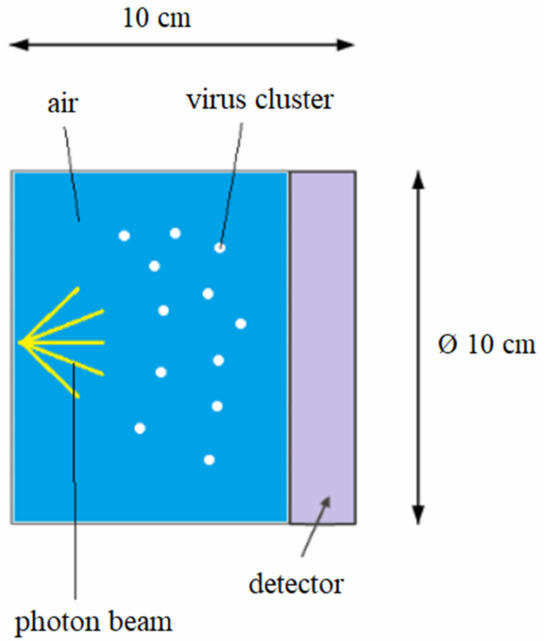
Figure 2. Physical model x–z section of air sample and virion particles.